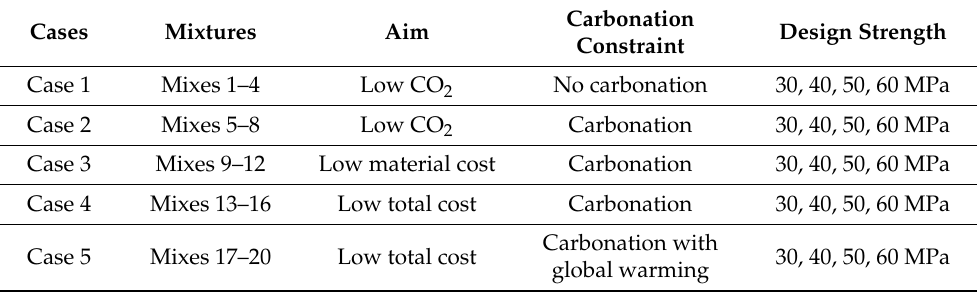
Table 4. Optimal design cases of SF-modified concrete.